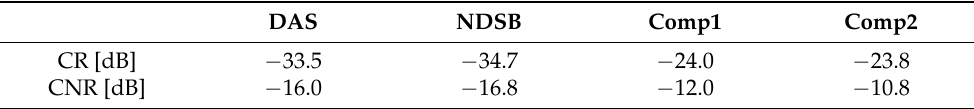
Figure 7. B-mode images of cross-section carotid artery and the jugular vein in 50-dB range. ( a ) DAS image ( b ) NDSB image ( c ) Comp1 image ( d ) Comp2 image. Table 3. Contrast-ratio and Contrast-to-noise ratio for Figure 7.